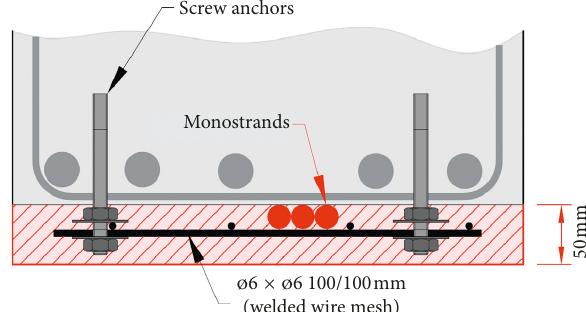
Figure 16: The arrangement of additionally anchored protective concrete covering layer (secondary corrosion protection of